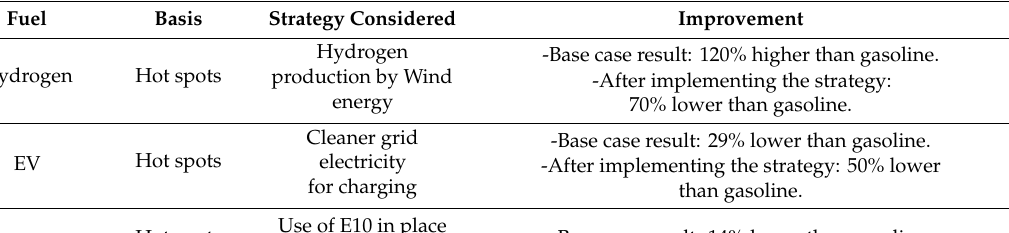
Table 10. Improvement of GHG emission by applying scenario